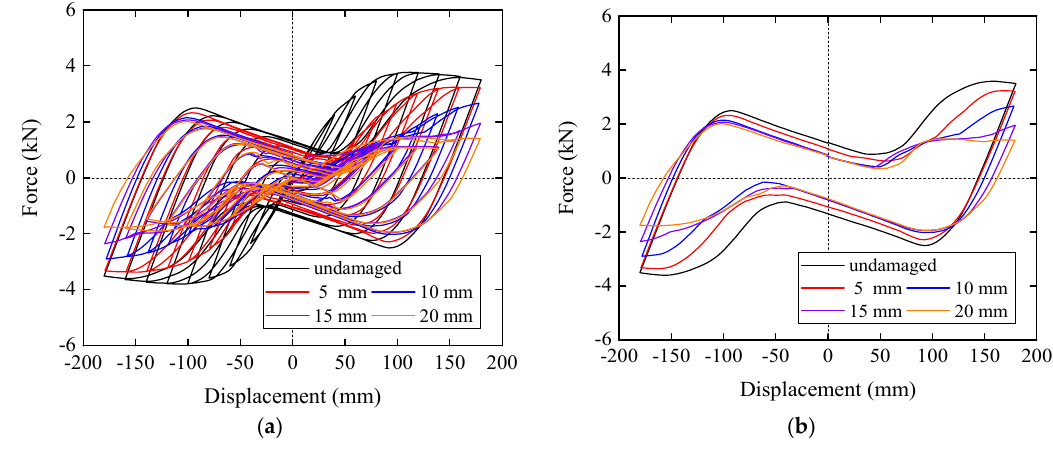
Figure 21. Hysteresis curves: ( a ) All cycles; ( b ) last cycle.